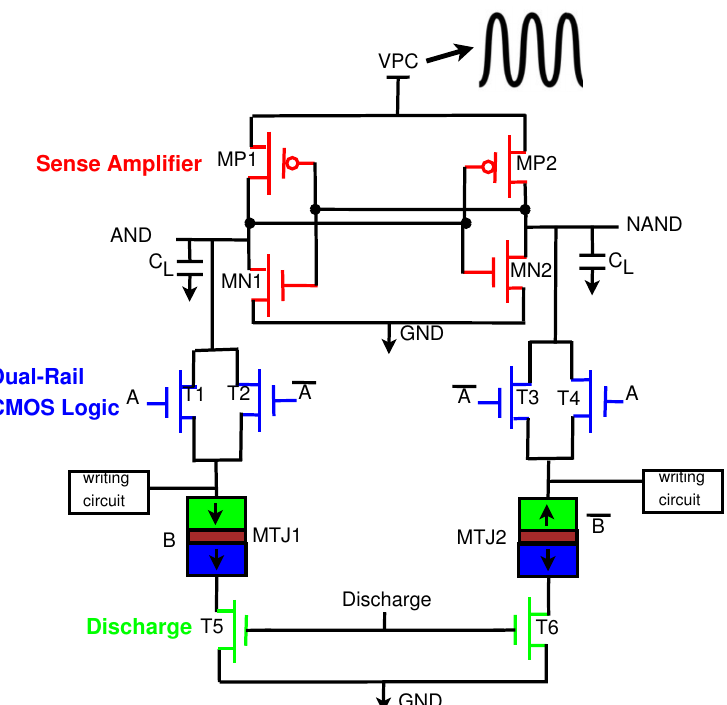
Figure 9. Proposed Energy-Efficient Adiabatic CMOS/MTJ AND/NAND